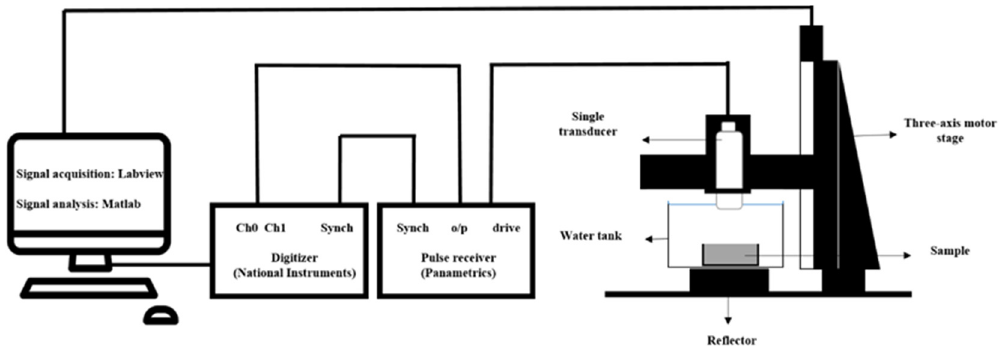
Figure 3. Scanning acoustic macroscope (SAMa) system.